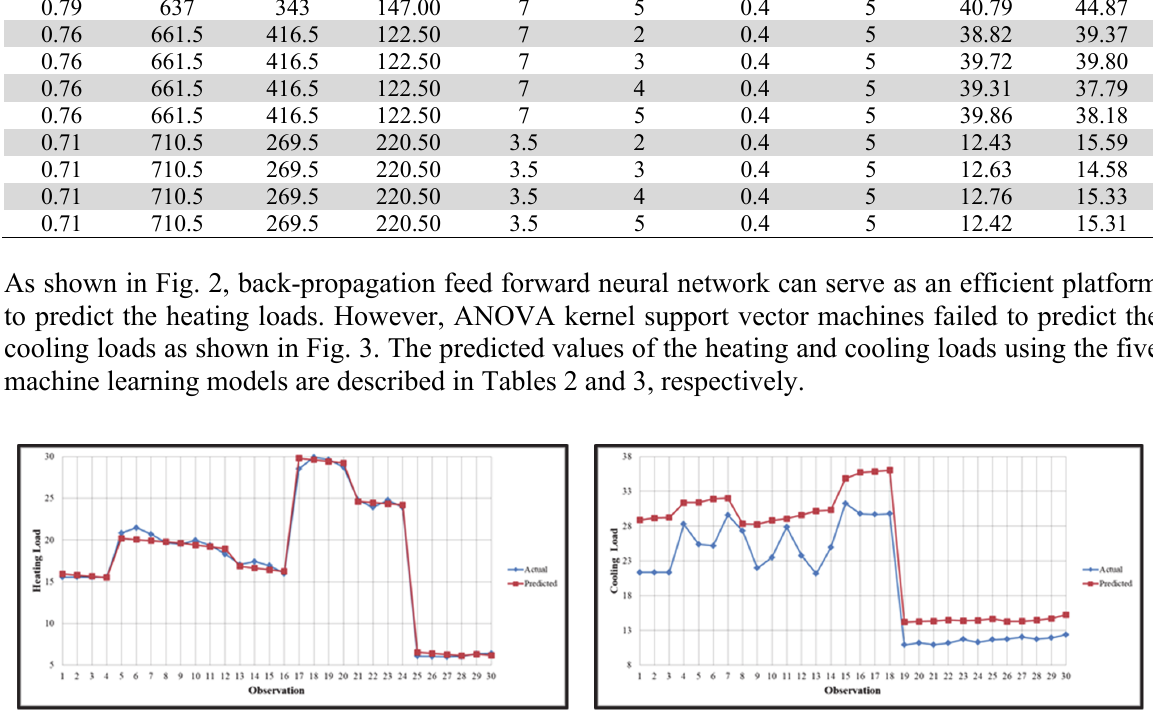
Fig. 3. Actual and predicted cooling loads using ANOVA kernel support vector machines